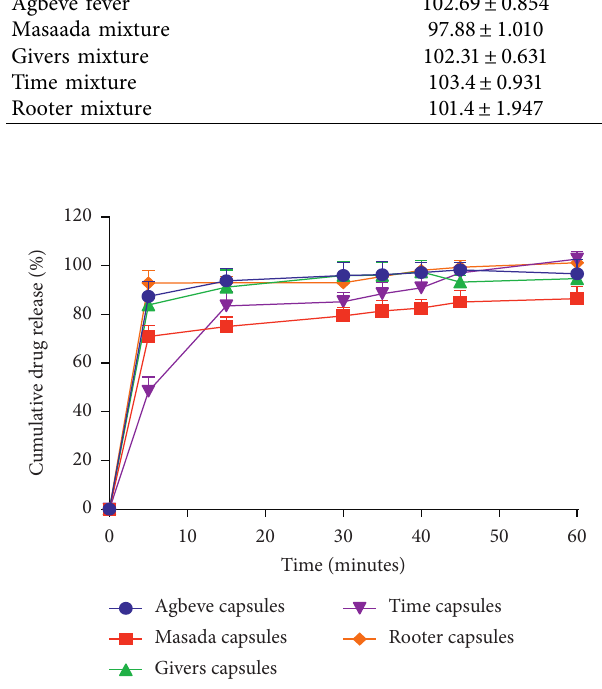
Figure 5: Dissolution profile of formulated Agbeve, Masada, Givers, Time, and Rooter capsules ( n � 6).